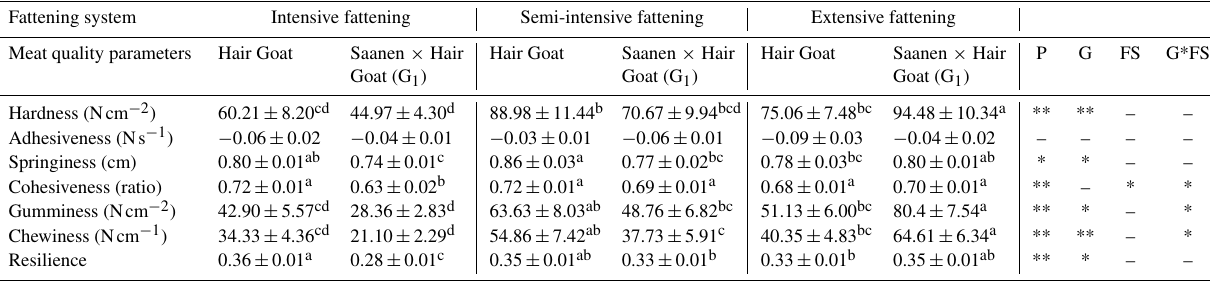
Table 6. Texture profile analysis of Hair Goat and Saanen × Hair Goat (G 1 ) crossbred kids. Fattening